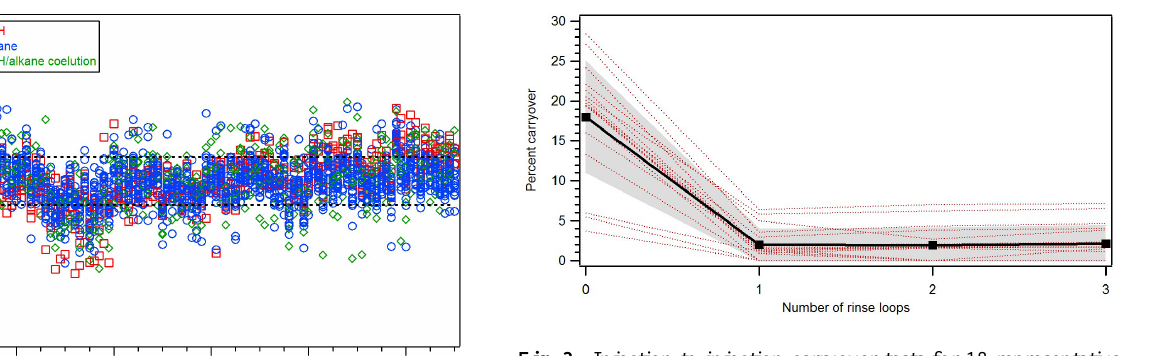
Fig. 3. Injection-to-injection carryover tests for 18 representative compounds (dashed red lines) and overall average (solid black line with standard deviation in gray area). Compounds shown are a selection of deuterated alkanes (n-hexadecane-d 34 , n-eicosane-d 42 , n-tetracosane-d 50 , n-octacosane-d 58 , n-dotriacontane-d 66 ), deuter- ated polycyclic aromatic hydrocarbons (dPAHs; phenanthrene-d 10 , fluoranthene-d 10 ), straight chain acids (hexadecanoic acid, octade- canoic acid, eicosanoic acid), PAHs (phenanthrene, fluoranthene), and other atmospheric relevant compounds (5 α -cholestane-d 6 , 5 α - cholestane, 2-pentadecanone, retene, benzophenone, and dihydro-